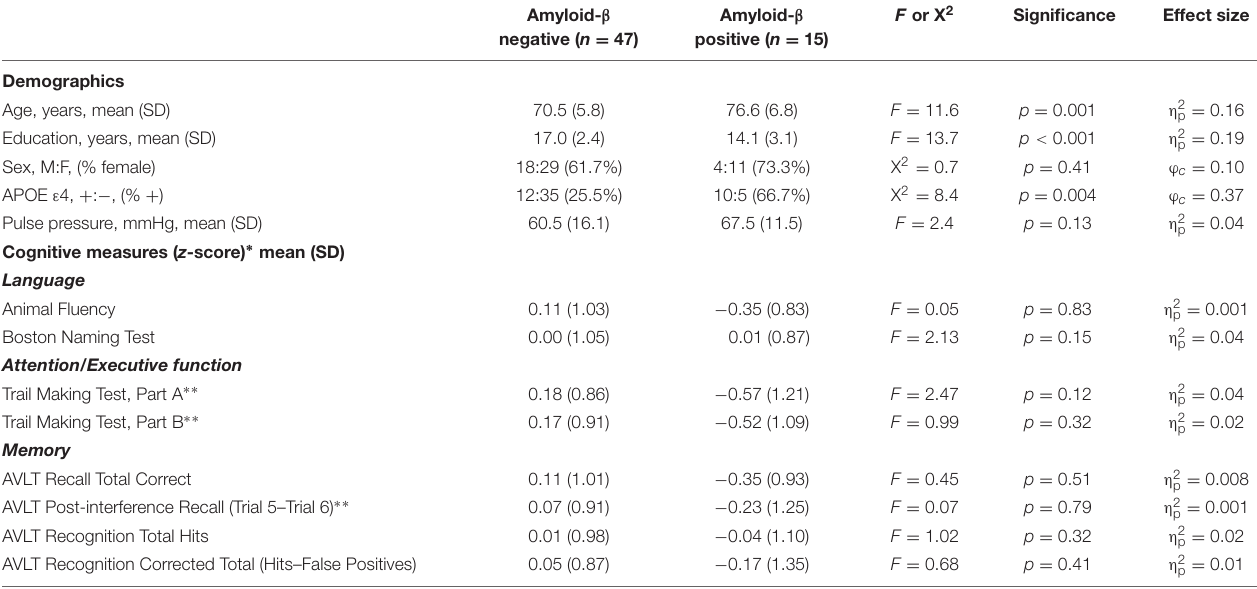
TABLE 1 | Demographic and neuropsychological characteristics of amyloid negative and amyloid positive